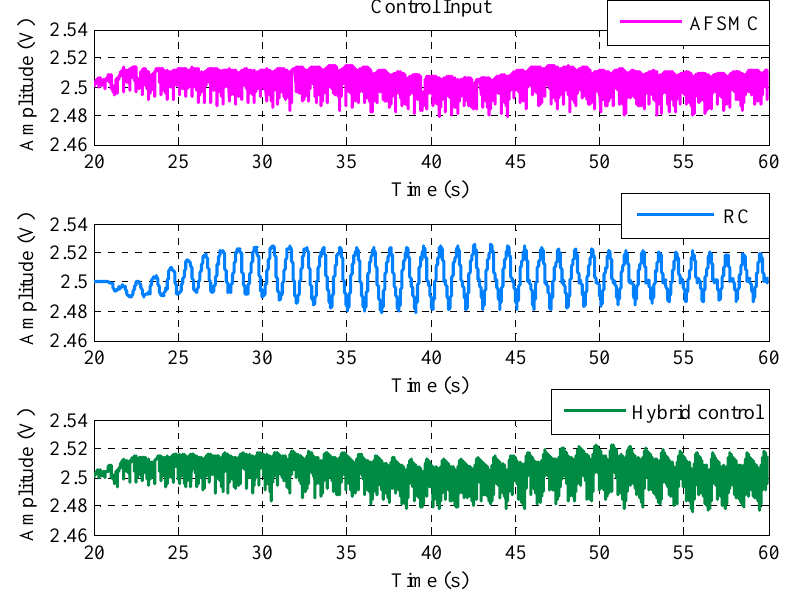
Figure 14. Piezoelectric vibration control for the flexible structure system: control input.